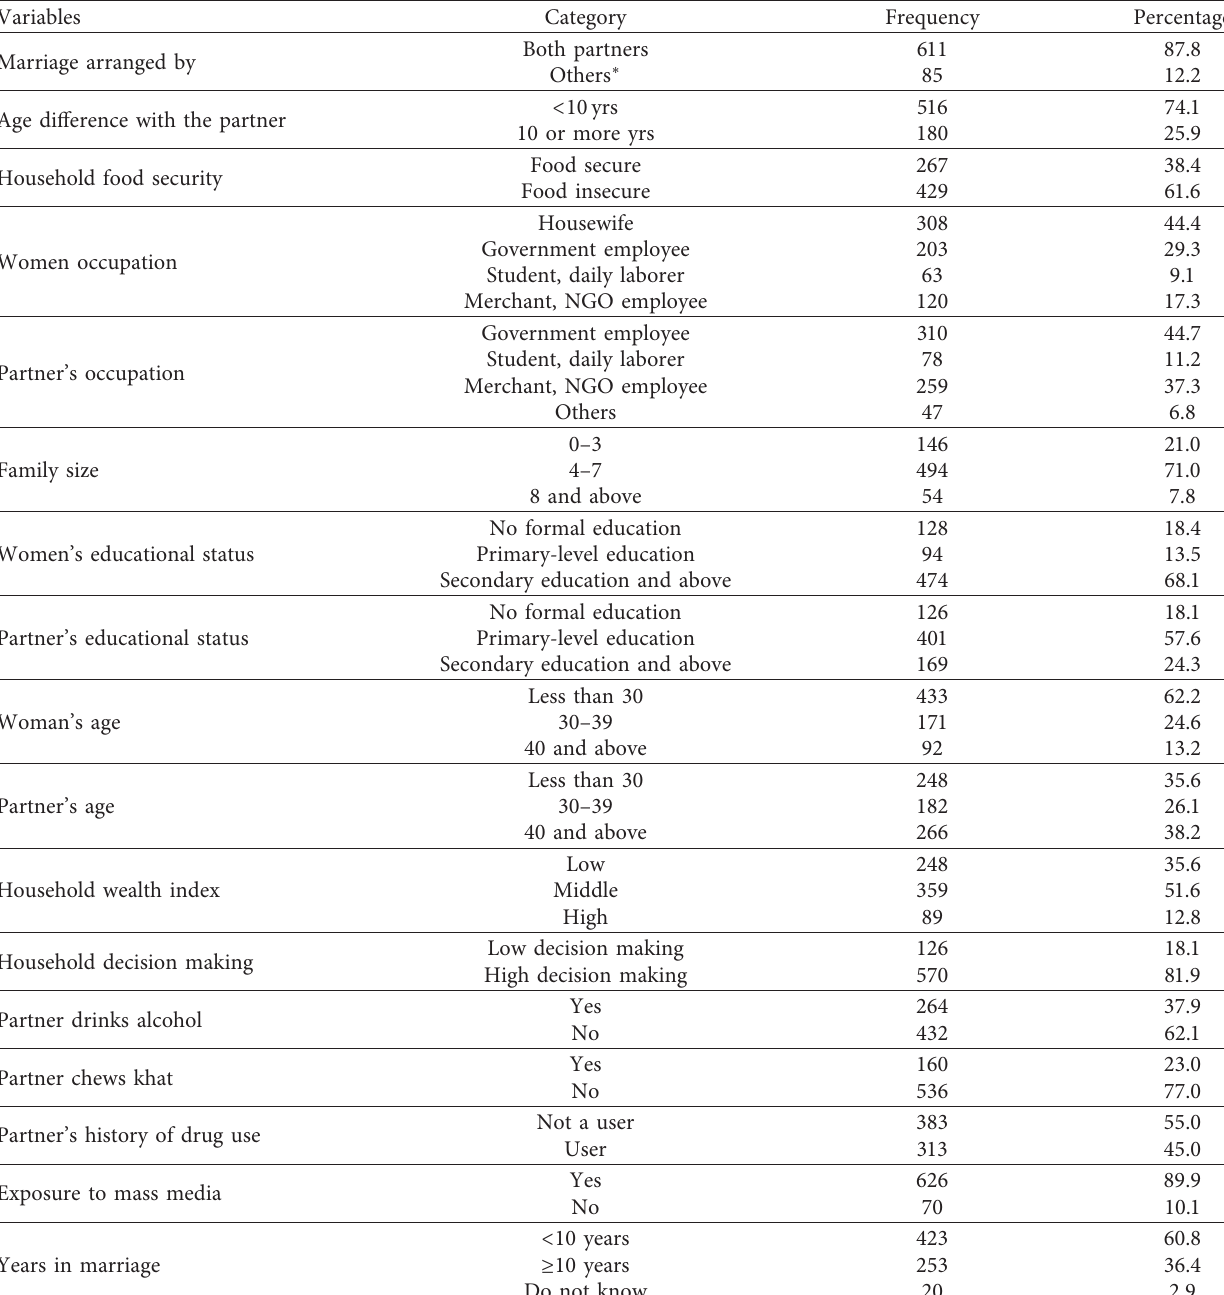
Table 1: Individual and household characteristics of currently married women at Arba Minch town, Southern Ethiopia, March 2017.